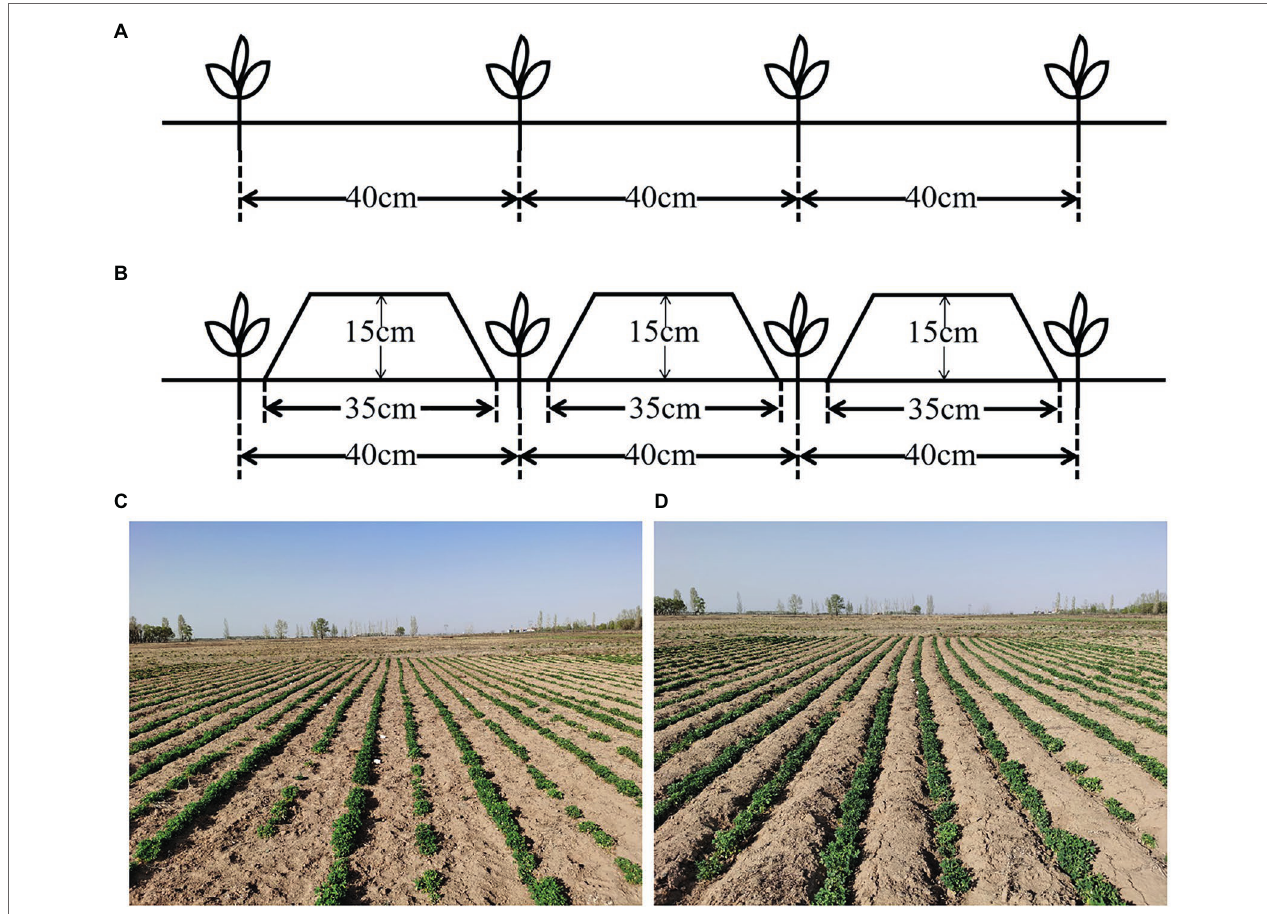
FIGURE 2 | Schematic diagram of (A) flat-bed seeding (FL) or (B) furrow-bed seeding (FU) systems and the pictures of field experiment in the seedling stage of FL (C) or FU (D)